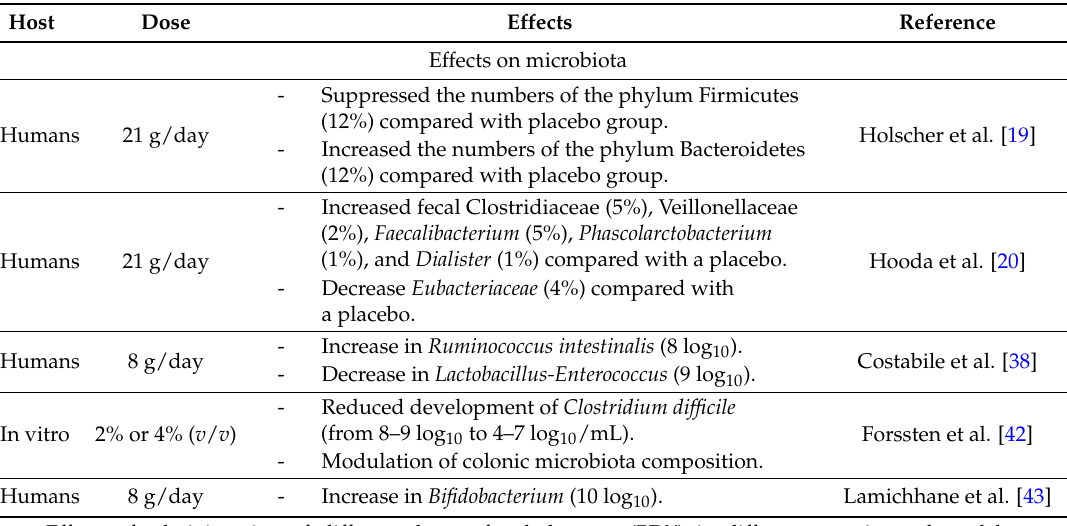
Table 2. The effects of administration of polydextrose on